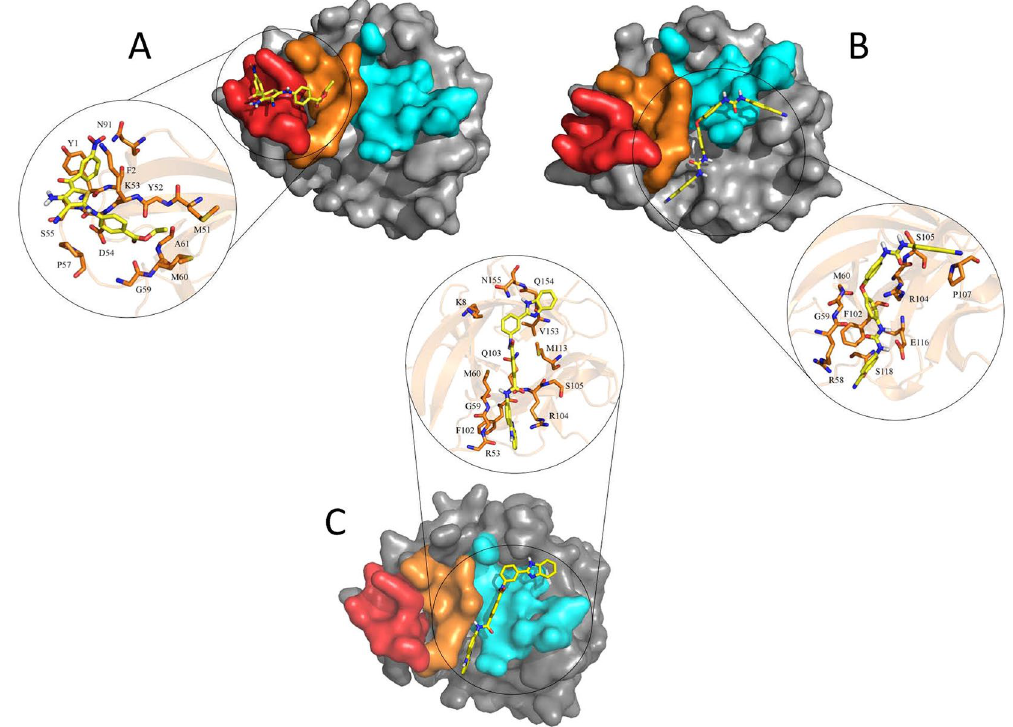
Figure 3. Virtual Docking of Identified Compounds. Autodock docking poses of compounds ( A ) NSC201631, ( B ) NSC80734, and ( C ) NSC61610. The docked conformation with the most favorable binding free energy and the most populated cluster was selected as the best result. Previously identified binding sites on hIL-18 colored as site A (red), site B (orange), and site C (cyan) with the remaining surface of hIL-18 is colored in grey. Each individual compound is colored in yellow and shown using a stick figure. Zoomed inserts for each figure illustrate the predicted interactions of the compound with hIL-18 residues. For clarity, non-interacting residue sidechains have been omitted. Compound NSC201631 docked with a predicted potential of 8 hydrogen bonds and 25 hydrophobic interactions; NSC80734 docked with a predicted potential of 8 hydrogen bonds and 24 hydrophobic interactions; NSC61610 docked with a predicted potential of 10 hydrogen bonds and 26 hydrophobic interactions.